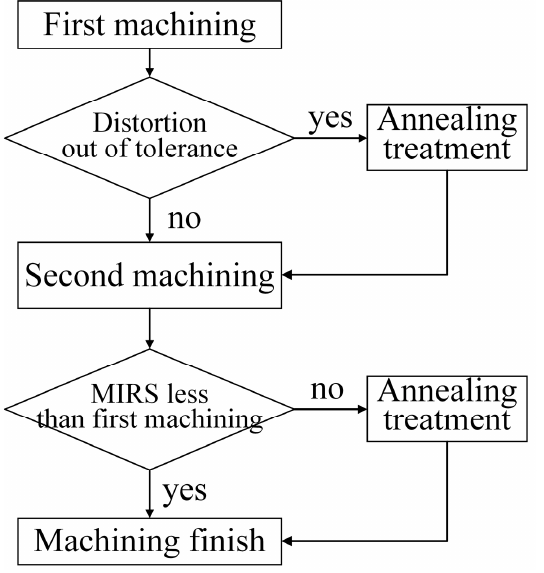
Figure 10. Process planning of annealing treatment in multiple manufacturing sequences.